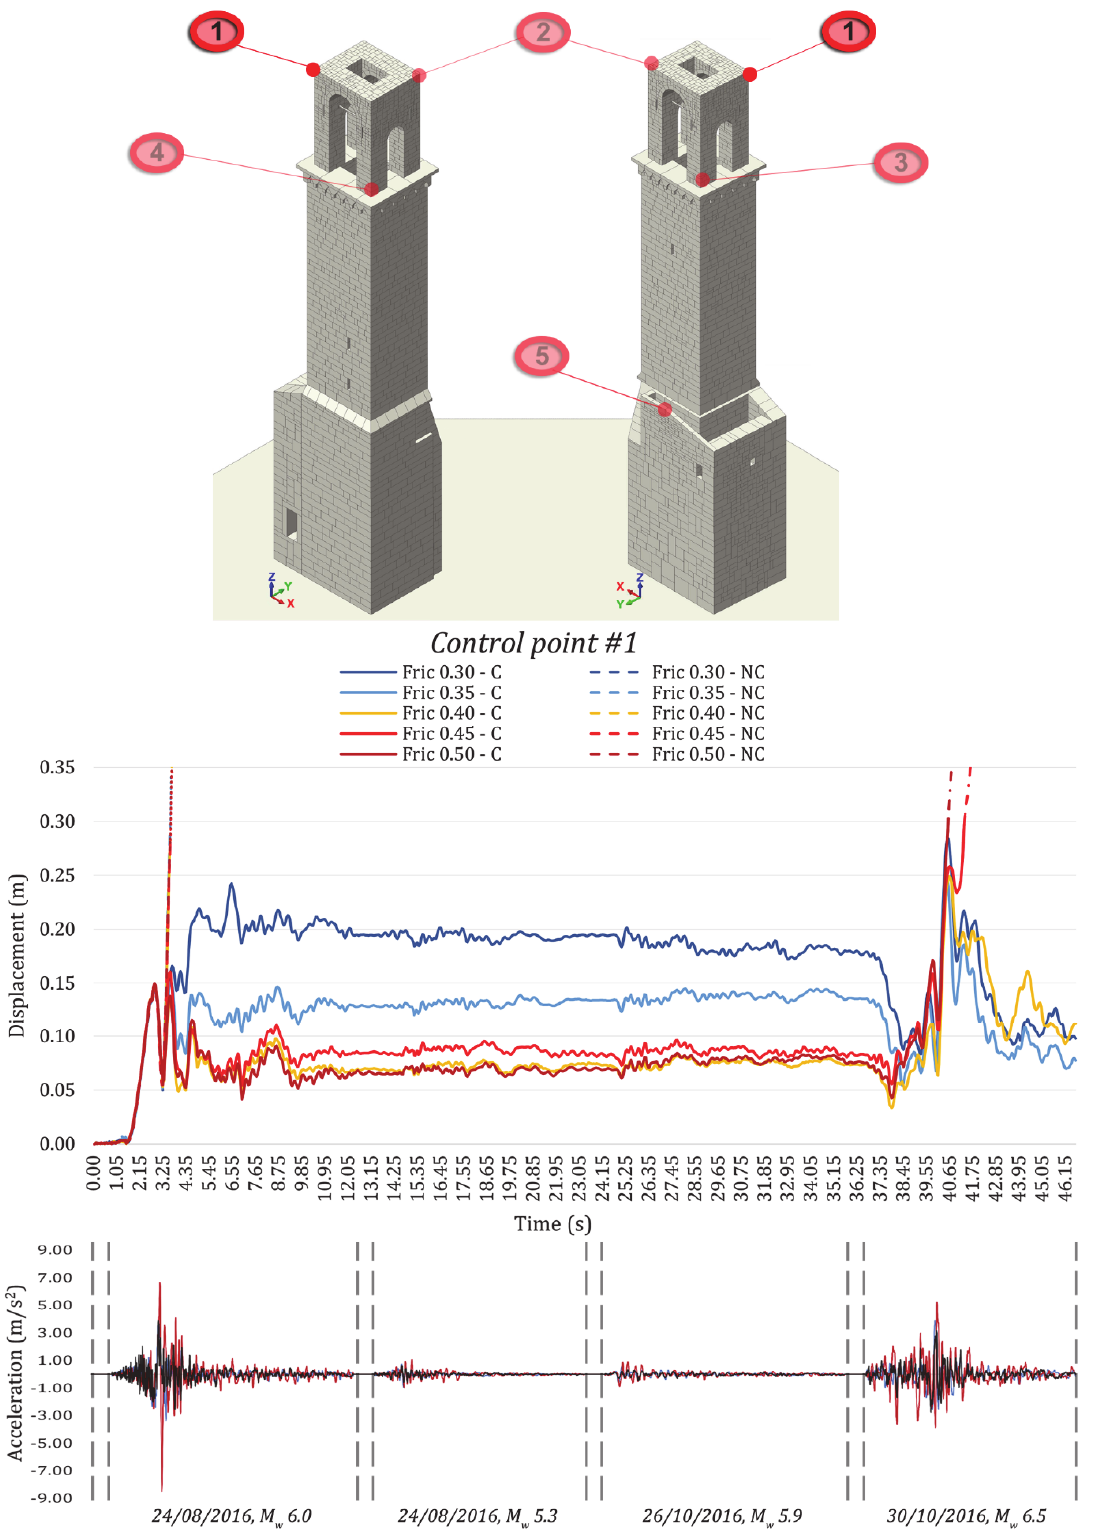
Figure 16: Displacements time histories of the control point #1 of the civic clock tower of Amatrice (Rieti, Italy) under the four main shocks in the three components x,y,z recorded in the village during the Central Italy seismic sequence of 2016 for both configurations, with (namely C) and without (NC) the steel chains, at varying of the friction on the bell